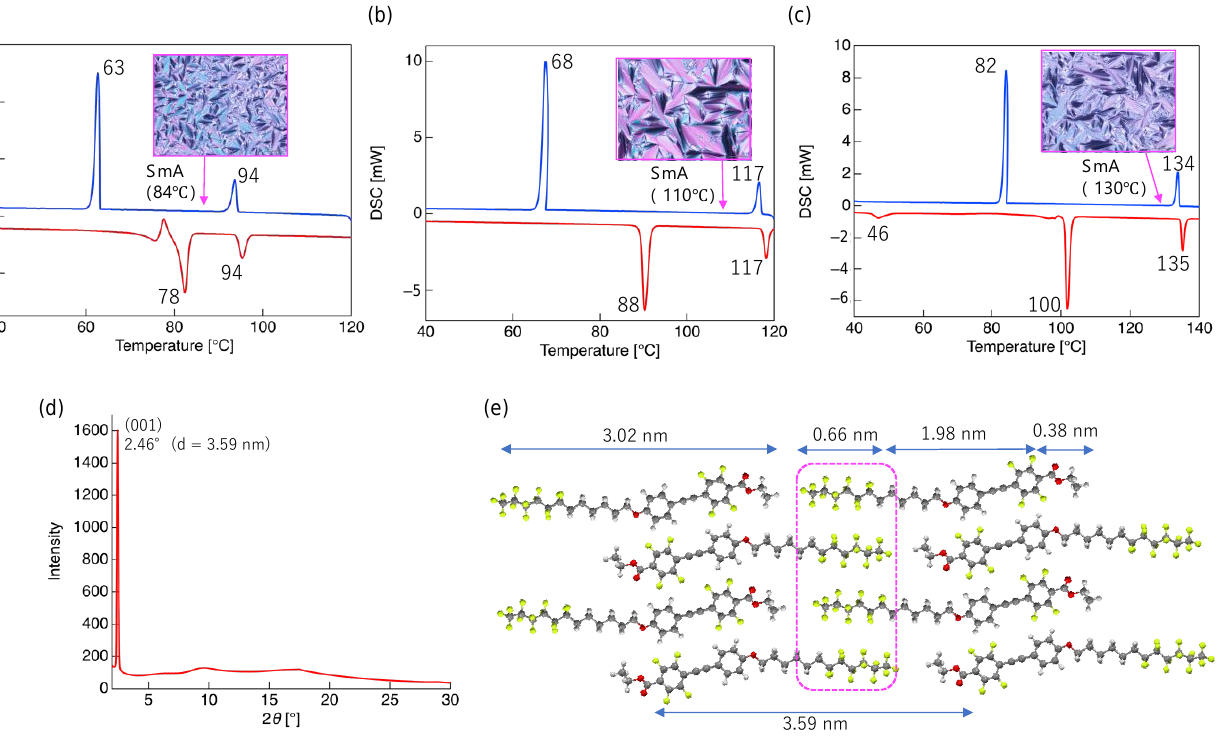
Figure 5. DSC thermogram and POM optical texture in the mesophases of ( a ) 2a , ( b ) 2c , and ( c ) 2d . Scan rate: 5.0 ◦ C min − 1 . ( d ) VT-PXRD pattern and ( e ) possible aggregated structures of 2c in the mesophase.